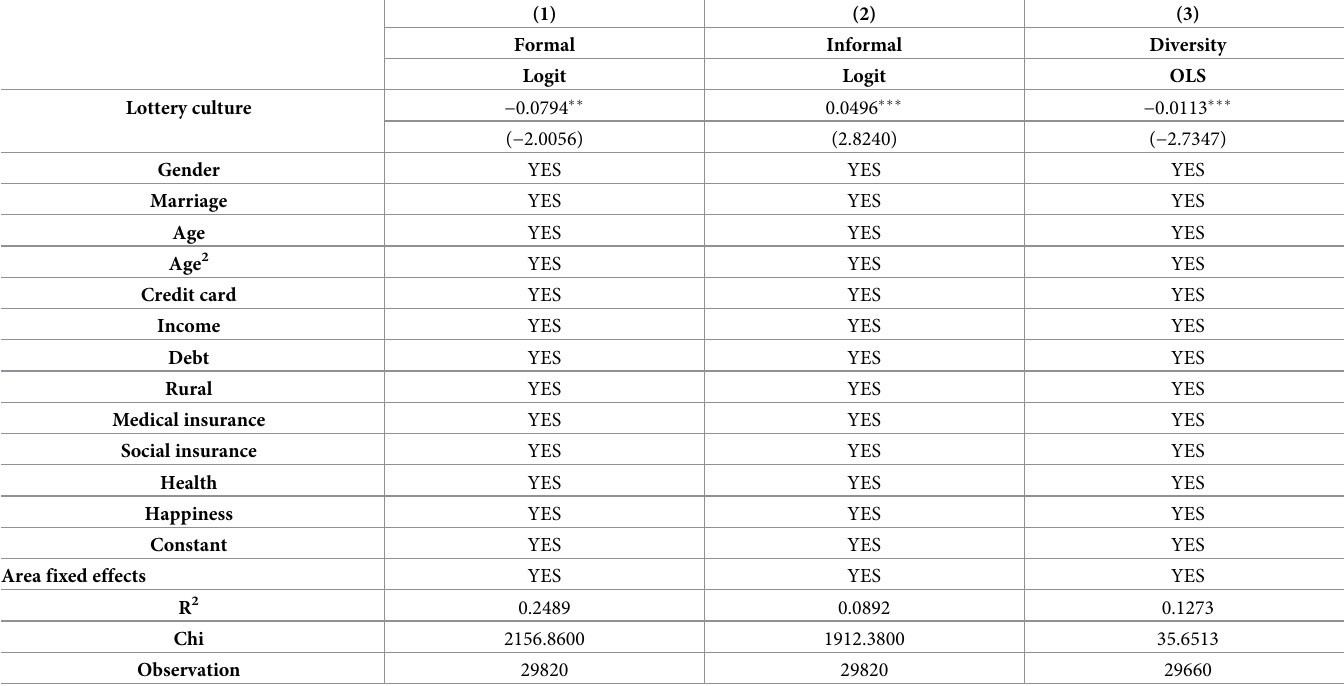
Table 4. “Lottery culture” and household financial decisions (alternative proxies of explained